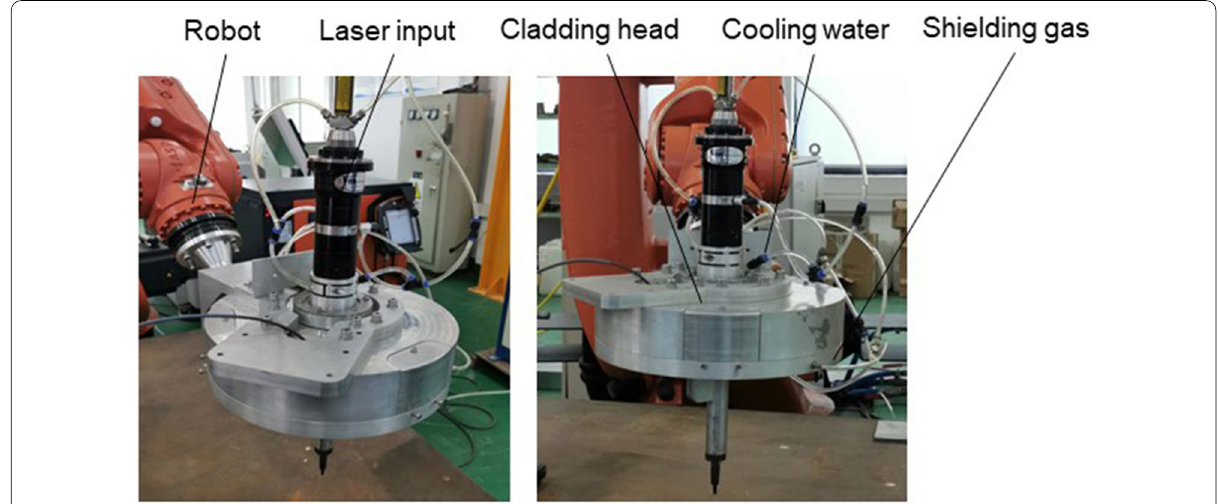
Figure 2 Cladding experimental setup